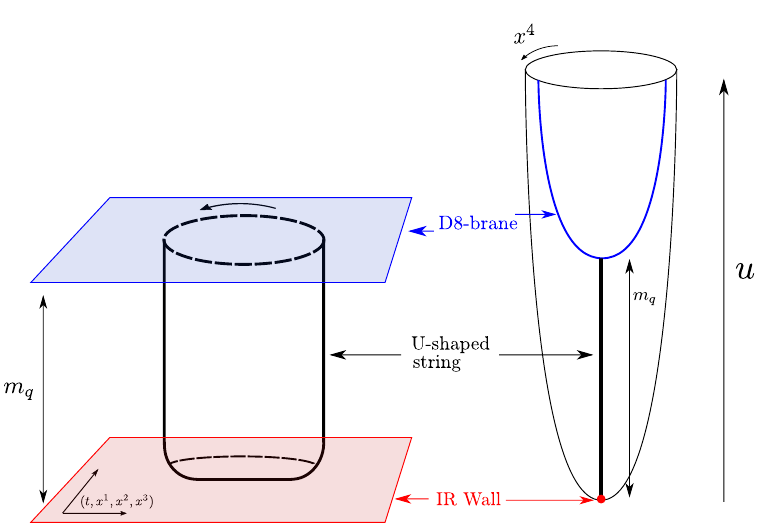
Figure 3 . Sakai-Sugimoto background with the probe D8-brane and the U-shaped, mesonic string which hangs in the holographic direction towards the wall at u = u (cid:3)